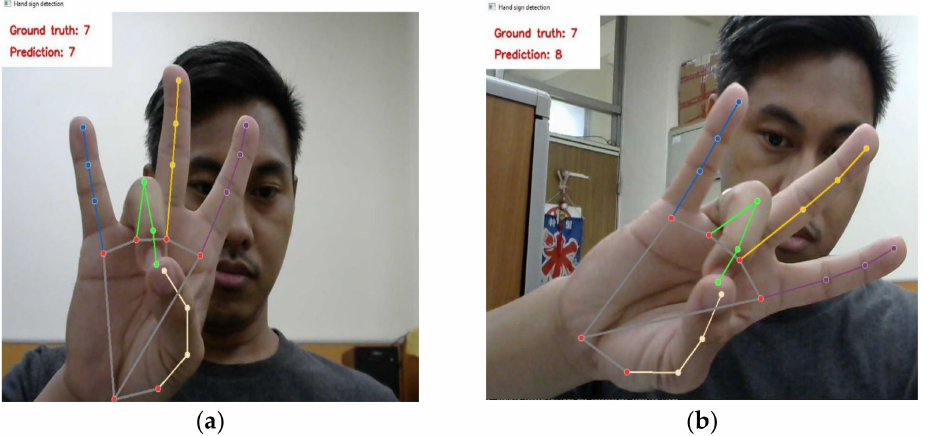
Figure 7. Prediction result using Dataset 1 and 10 features: ( a ) correct prediction; ( b ) incorrect